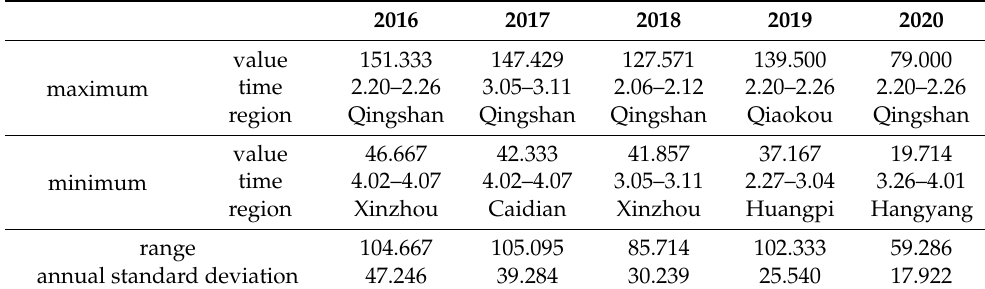
Table 9. PM 2.5 maximum/minimum statistics from 2016 to